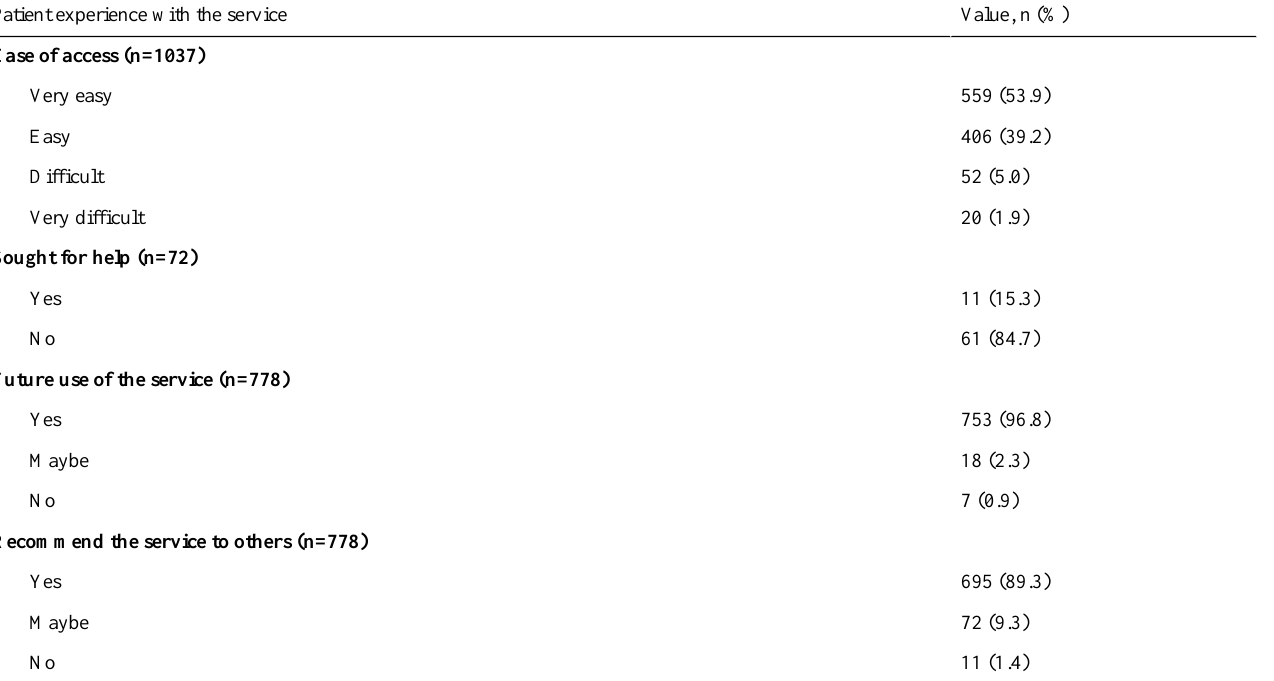
Value, n (%)Patient experience with the service